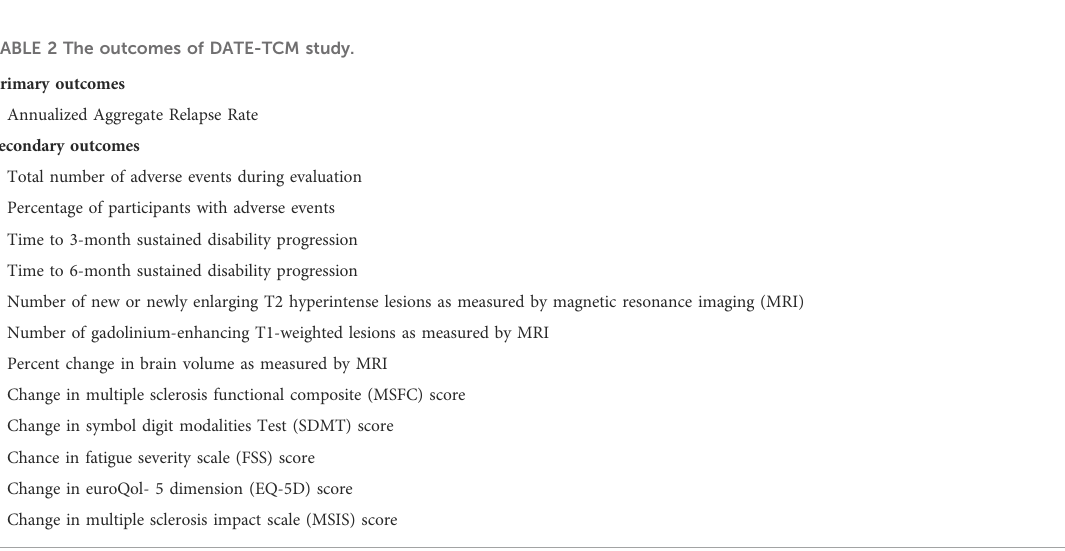
TABLE 2 The outcomes of DATE-TCM